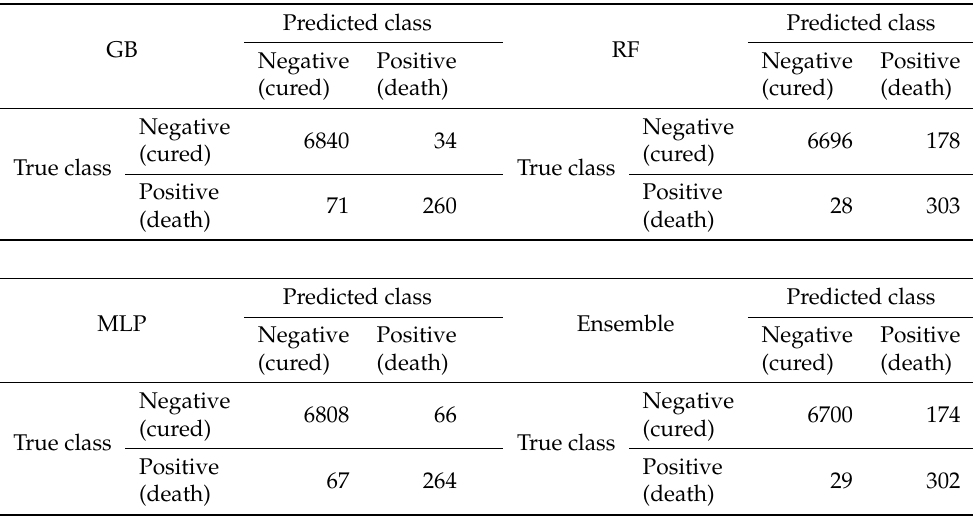
Table 7. Confusion matrix of Gradient Boosting (GB), Random Forest (RF), Multi-Layer Perceptron (MLP) and ensemble models using the imbalanced data set.